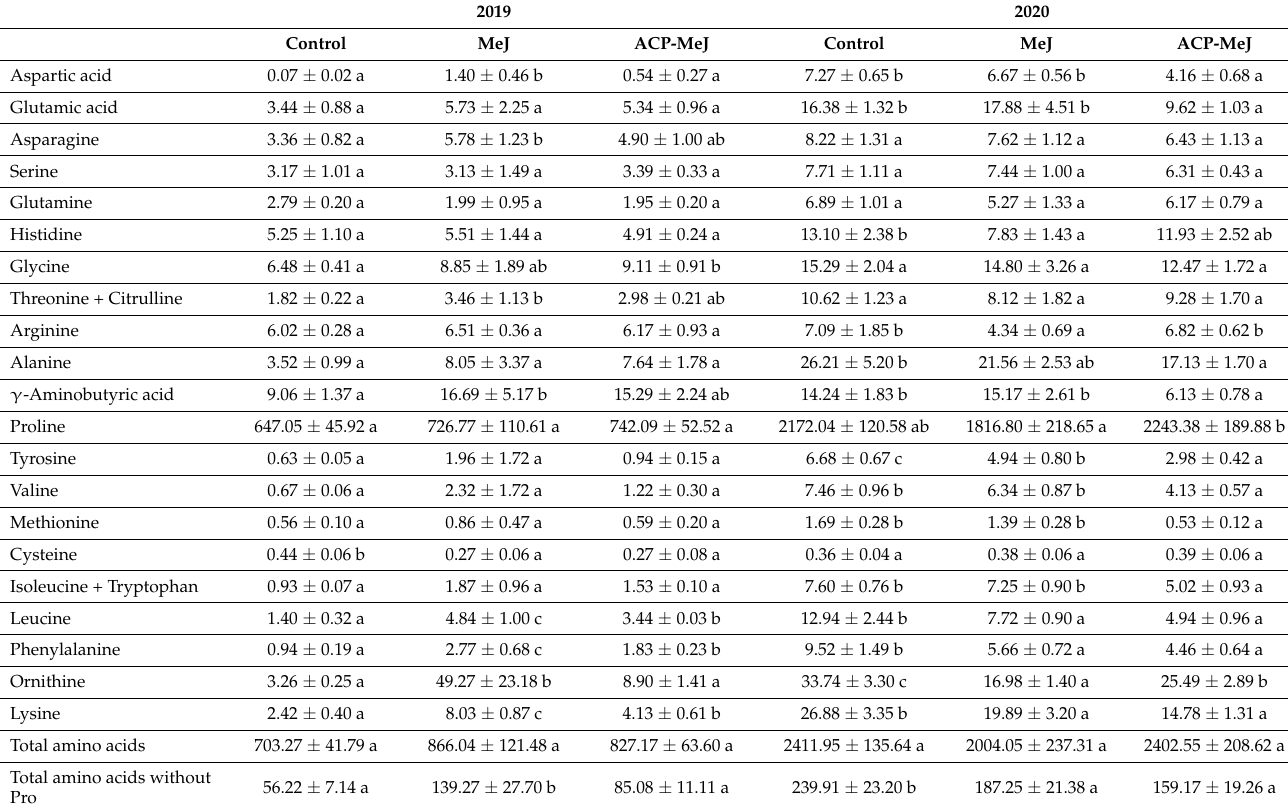
Table 4. Amino acids content (mg/L) in wines from control, methyl jasmonate (MeJ) and nanoparti- cles doped with this elicitor (ACP-MeJ) treatments, in 2019 and 2020